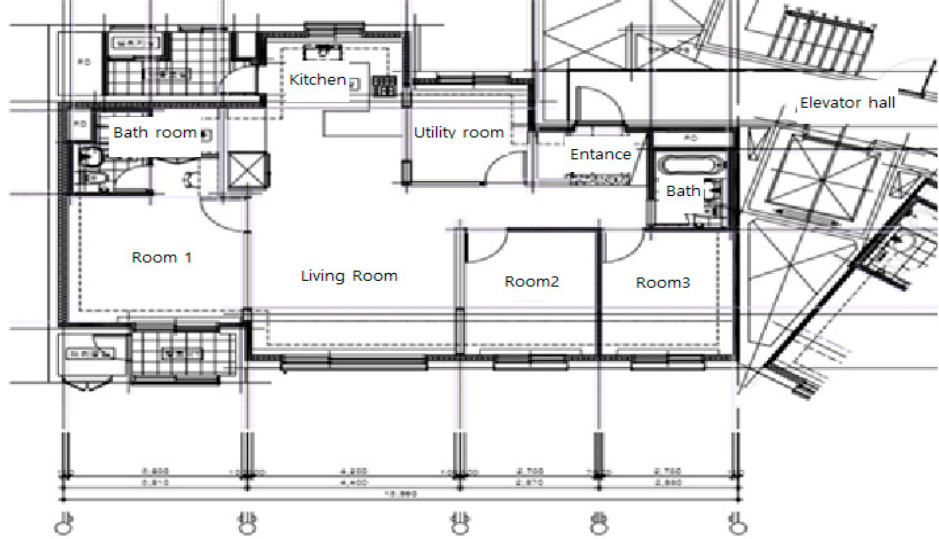
Figure 4. The unit floor plan of the target apartment.